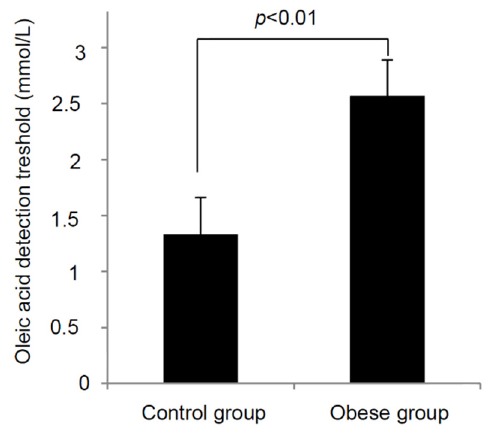
Figure 1. Relationship between BMI and oro ‐ sensory detection of a fatty acid in young leans and obese children. The oleic acid detection thresholds were determined in lean ( n = 82) and obese children ( n = 83) as described in the Materials and Methods section. The results are means ± SEM.